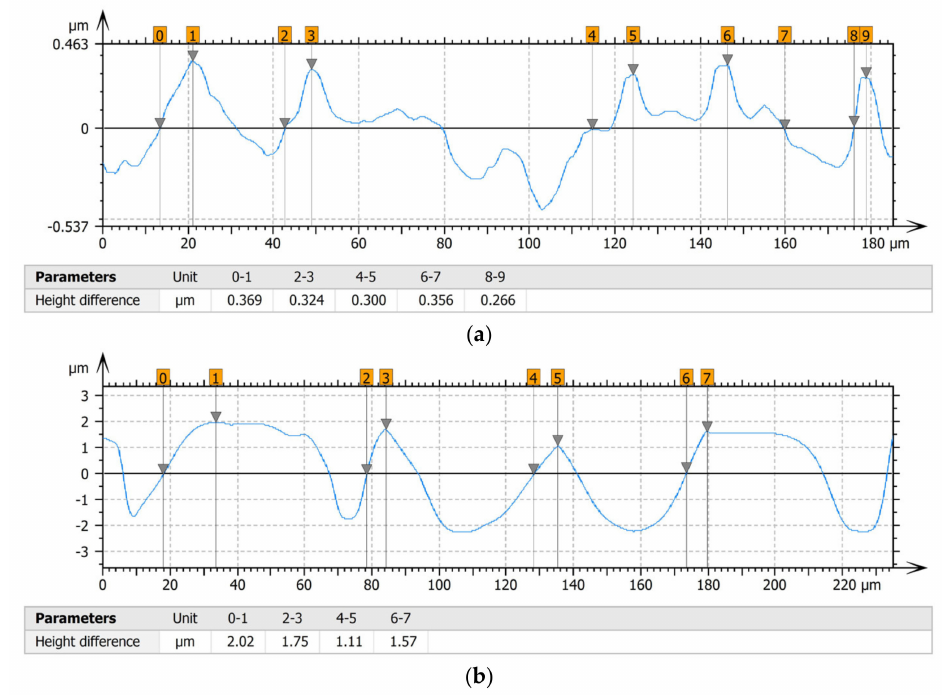
Figure 4. Peaks characteristics: ( a ) Surface A, ( b ) Surface